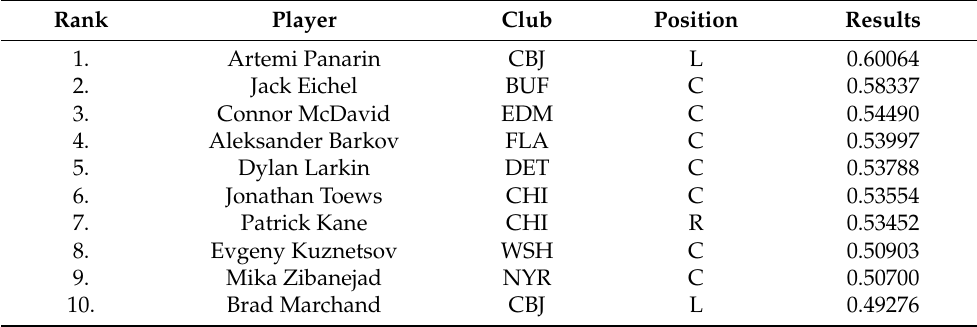
Table 4. Ten best players as evaluated by the CV–TOPSIS